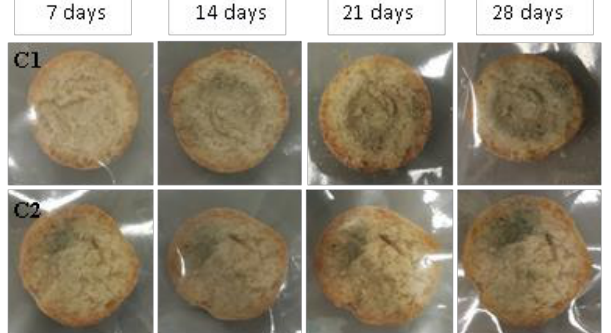
Figure 16. Examples of bread made from sourdoughs inoculated with the dual combination of isolates A21 and B01, then artificially contaminated with Penicillium roqueforti and incubated at room temperature for 7, 14, 21, and 28 days.